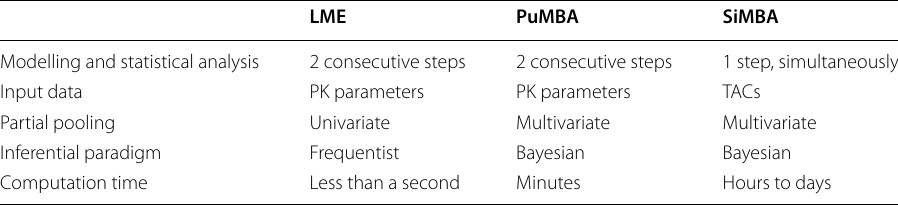
Table 1 Systematic comparison of the different methods applied LME PuMBA SiMBA Modelling and statistical analysis 2 consecutive steps 2 consecutive steps 1 step, simultaneously Input data PK parameters PK parameters TACs Partial pooling Univariate Multivariate Multivariate Inferential paradigm Frequentist Bayesian Bayesian Computation time Less than a second Minutes Hours to